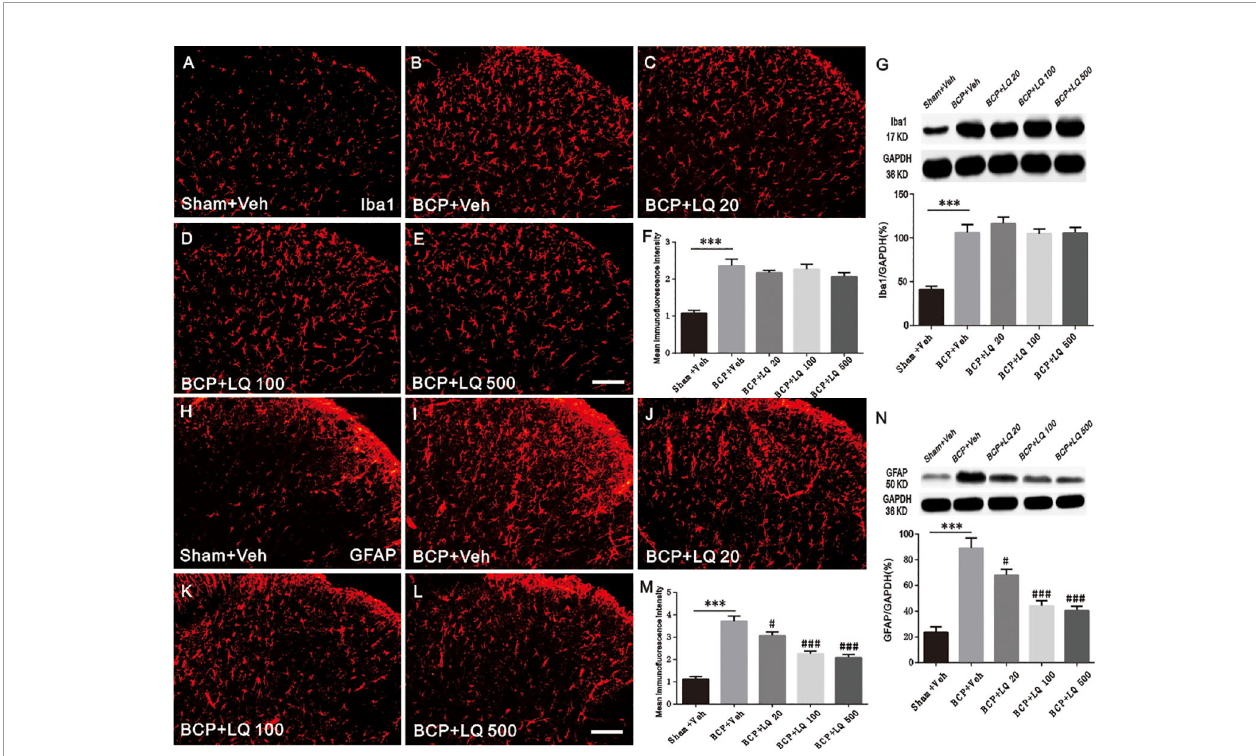
FIGURE 4 | Effect of intrathecal administration Liquiritin (LQ) on glial activation in the spinal dorsal horn of bone cancer pain (BCP) rats on postoperative day (POD) 12. (A – E) BCP induced a remarkable microglial activation, which was indicated by Iba1 upregulation in the ipsilateral spinal dorsal horn on POD 12. Intrathecal LQ administration did not inhibit the immunodensities of Iba1 in the ipsilateral spinal dorsal horn after BCP. Scale bar 100 m m; mean immuno fl uorescence intensity (F) and western blot (G) of Iba1 expressions after different treatments (F 4,15 = 18.54, ***P < 0.001 vs. sham + Veh group, P > 0.05 vs. BCP + Veh group; F 4,15 = 19.82, ***P < 0.001 vs. sham + Veh group, P > 0.05 vs. BCP + Veh group; n = 4, one way ANOVA, 4F, G ). (H – L) BCP induced activation of astrocytes remarkably, which was indicated by GFAP upregulation in the ipsilateral spinal dorsal horn on POD 12. Intrathecal LQ administration inhibited immunodensities of GFAP in the ipsilateral spinal dorsal horn after BCP. Scale bar 100 m m; mean immuno fl uorescence intensity (M) and western blot (N) of GFAP expressions after different treatments (F 4,15 = 37.49, ***P < 0.001 vs. sham + Veh group; # P < 0.05, ### P < 0.001 vs. BCP + Veh group; F 4,15 = 25.18, ***P < 0.001 vs. sham + Veh group; # P < 0.05, ### P < 0.001 vs. BCP + Veh group; n = 4, one way ANOVA, 4M, N